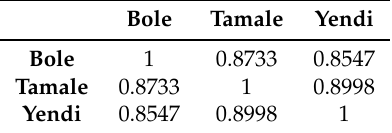
Table 3. Correlation matrix of the de-seasonalized daily average